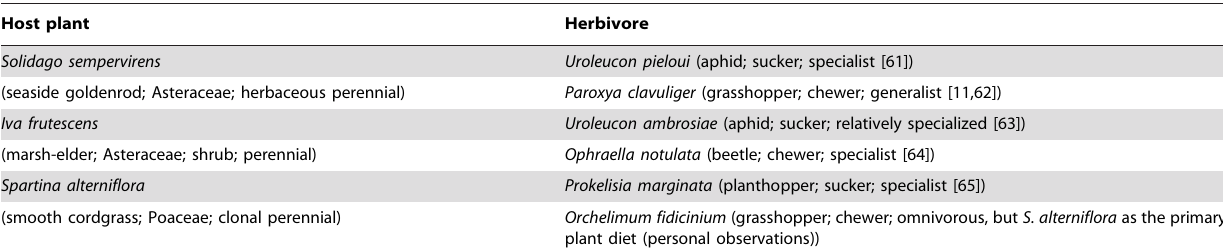
Table 2. Plant and herbivore species